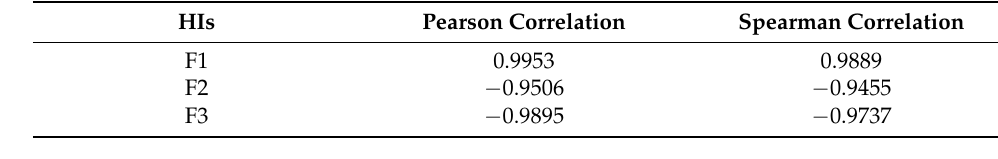
Table 1. Results of correlation analysis of three HIs. HIs Pearson Correlation Spearman Correlation